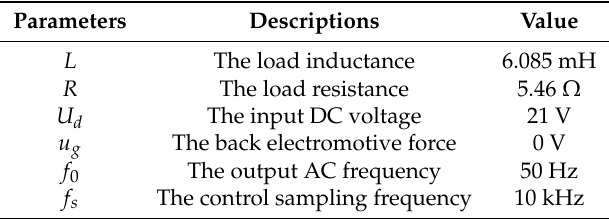
Table 3. Experimental